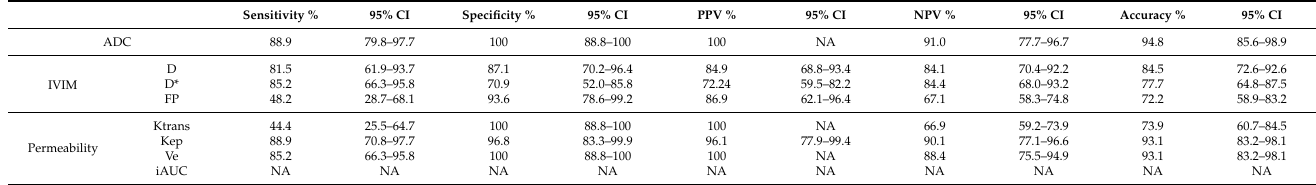
Table 6. Diagnostic accuracy of IVIM- and DCE-derived